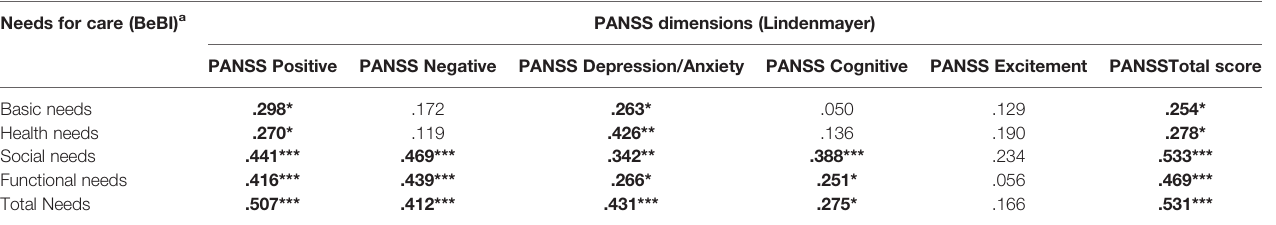
TABLE 3 | Association of psychopathology with needs for care (Spearman rank correlation). Needs for care (BeBI)